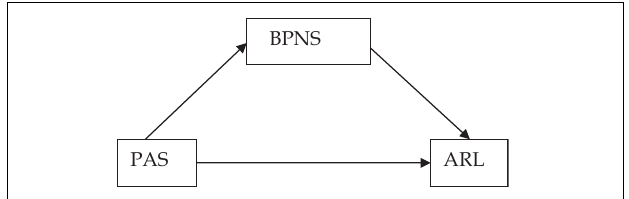
FIGURE 1 | Hypothesized relationships between PAS, BPNS, and ARL. PAS, parental autonomy support; BPNS, basic psychological need satisfaction; ARL, autonomous regulation of